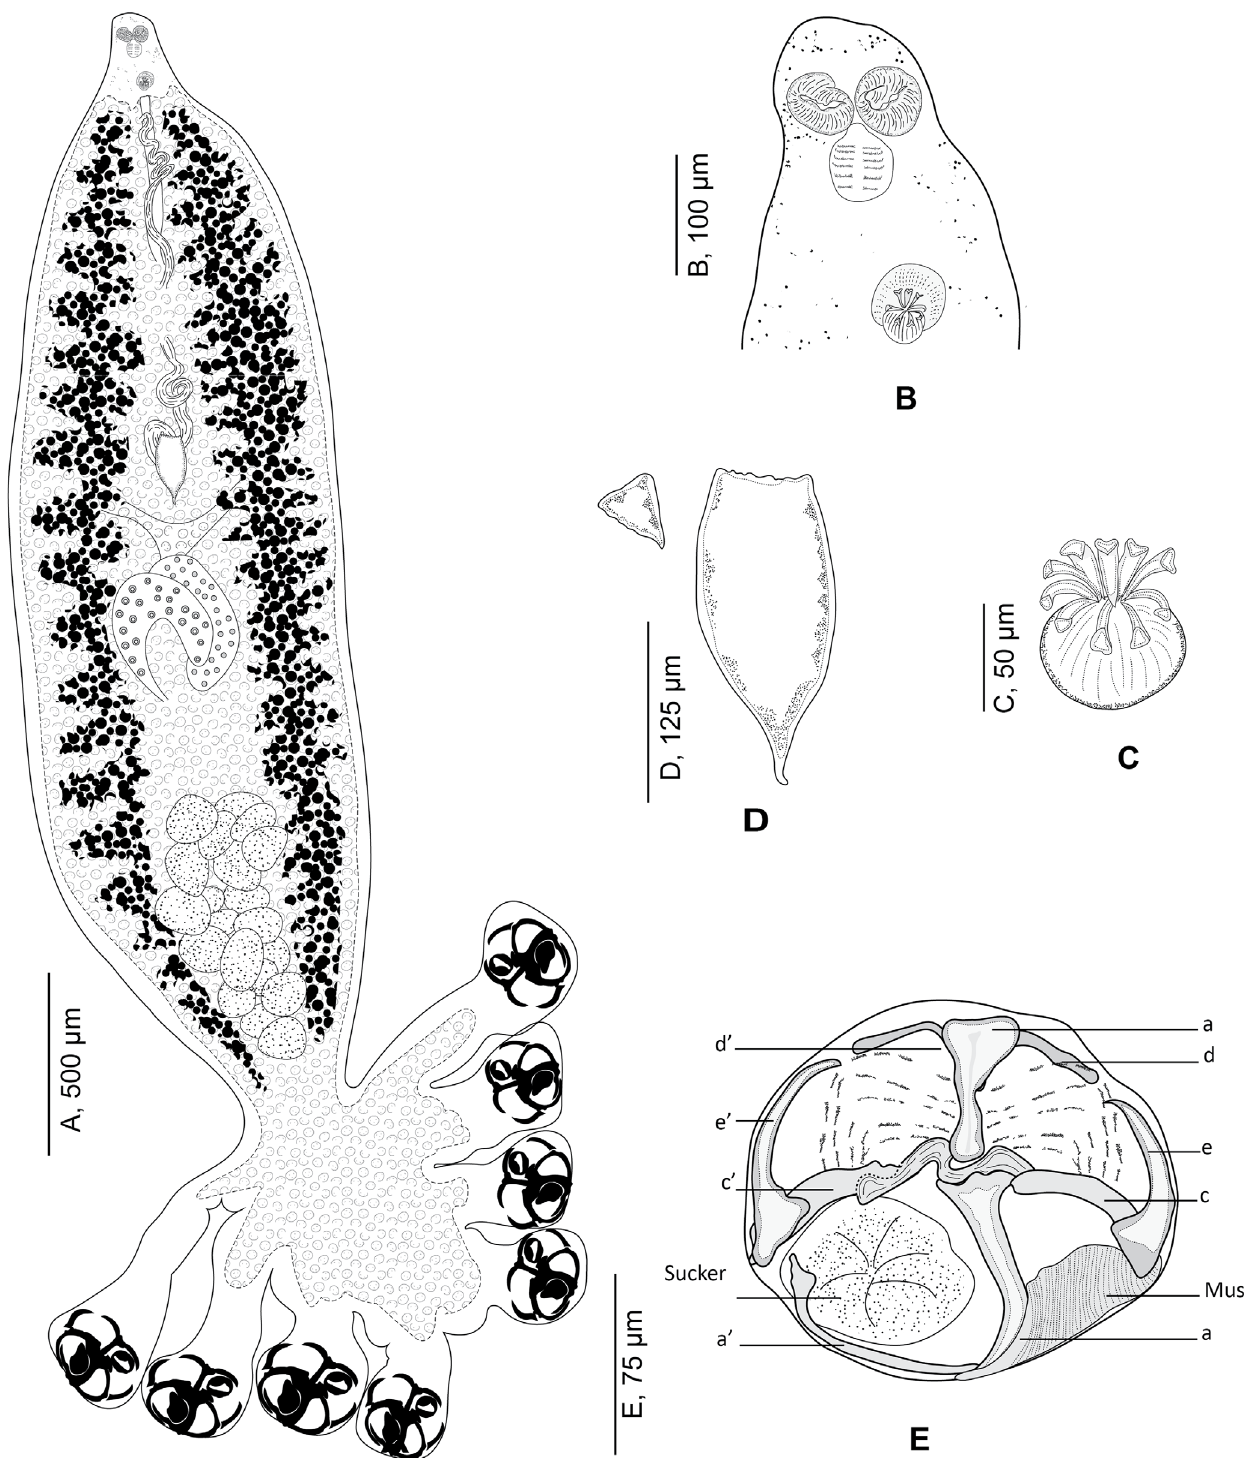
Figure 4. Choricotyle cf. chrysophryi Van Beneden & Hesse, 1863. A, whole body, MNHN HEL1329; B, anterior part showing relative position of prohaptoral suckers and male copulatory organ, MNHN HEL 1329. C, male copulatory organ, MNHN HEL1329; D, egg, MNHN HEL1329; E, clamp, MNHN